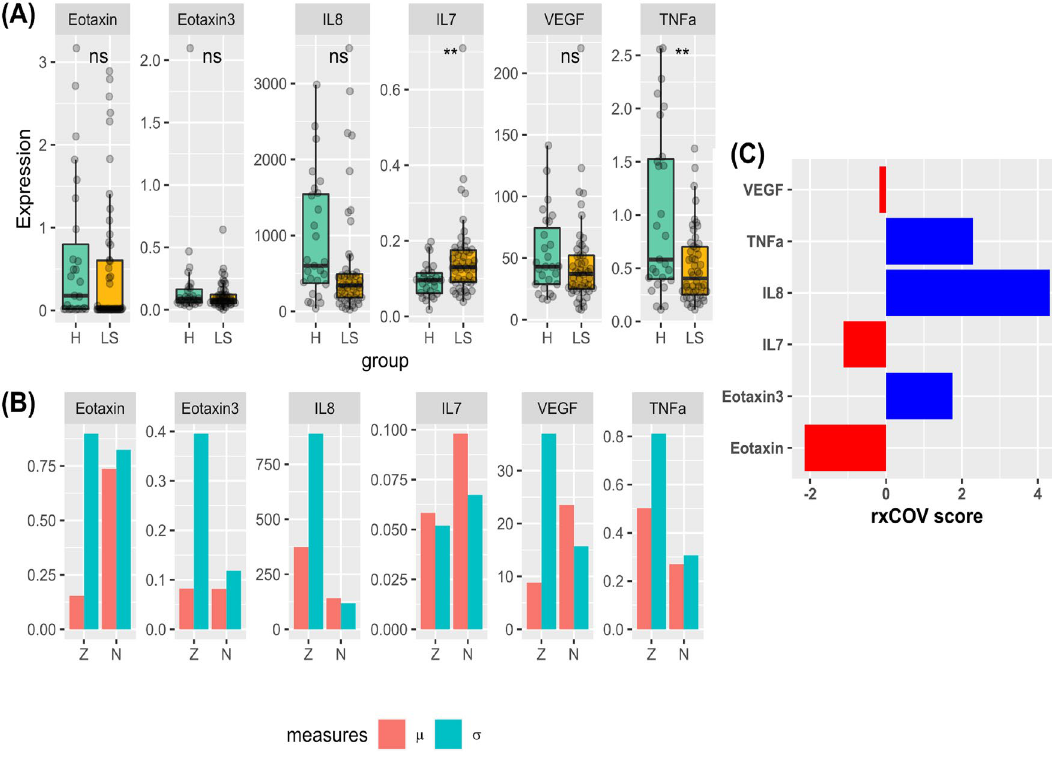
Figure 4. Case study. ( A ) Boxplot representation of multiplexed ELISA expression of six cytokines measured in Lynch Syndrome (LS) patients with healthy (H) patients acting as controls. ( B ) Barplots of the mean and standard deviation of the cytokine differential expressions ( Z ), and their corresponding assay-associated noise ( N ). ( C ) rx COV metric computed by substituting the mean and standard deviation of the differential expression, shown in ( B ), for each of the six cytokines . Those with rx COV > 0 are high-fidelity analytes and are shown in blue. Those with rx COV ≤ 0 are low-fidelity analytes and are shown in